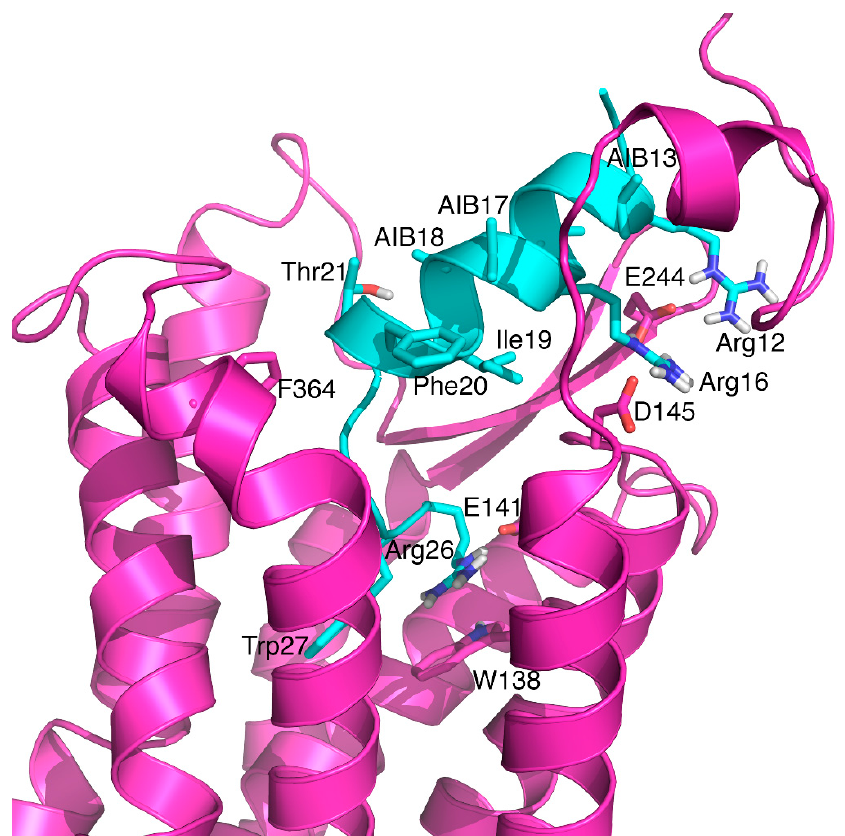
Figure 4. Model of analogue 4 bound to RXFP3. The predicted helical structure allows the same key interactions between arginine residues in relaxin-3 and acidic residues in RXFP3, as well as hydrophobic contacts [22]. Residues in analogue 4 are labelled with three-letter amino acid codes and residue numbers based on the relaxin-3 sequence, and residues in RXFP3 are labelled with single letter amino acid codes and residue numbers.